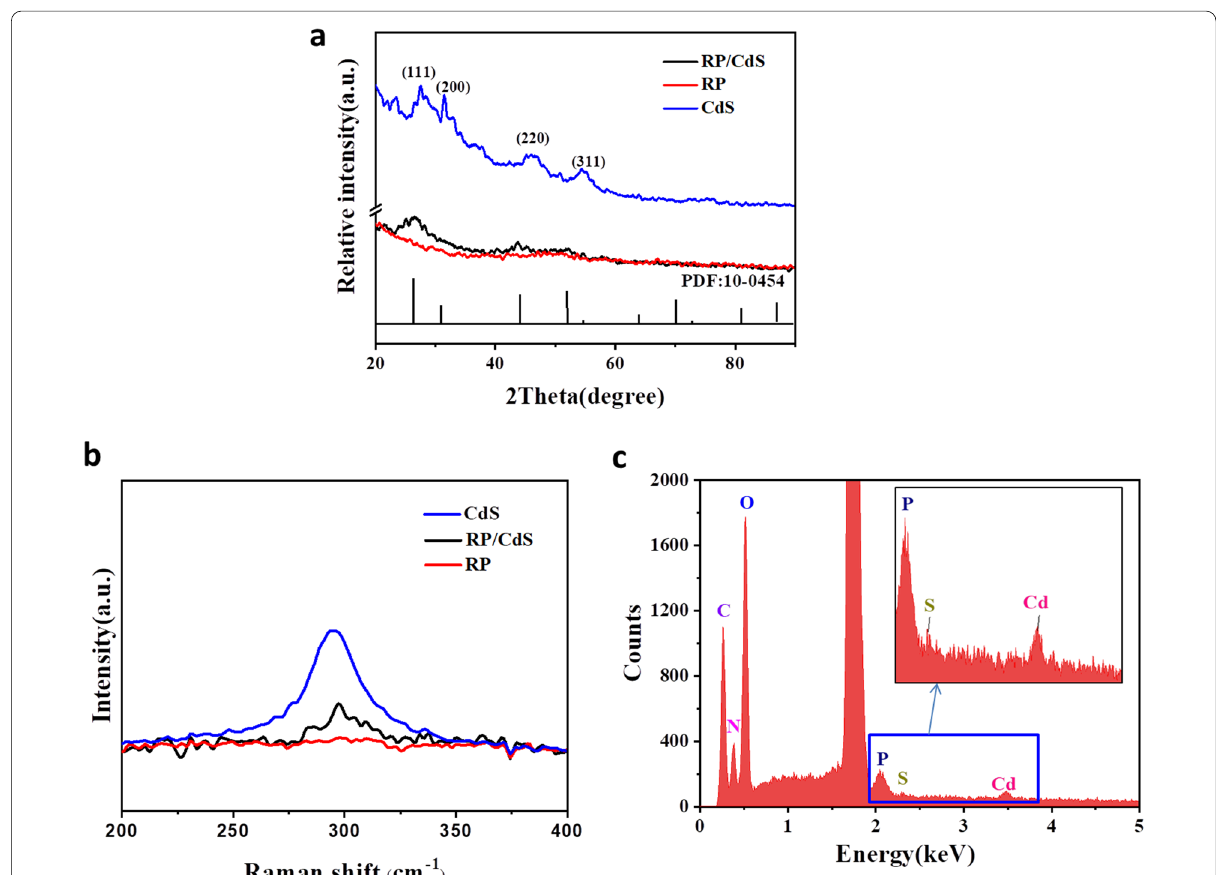
Fig.2 Physico‑chemical characterization of RP/CdS bio‑nano‑hybrid cells. a XRD patterns of CdS QDs, RP cells and RP/CdS hybrid cells. The number in the image indicates the crystalline facet of the corresponding peak. b Raman spectra of CdS QDs, RP cells and RP/CdS hybrid cells. c EDS analysis of RP/CdS hybrid cells. The inset indicates the enlarged view of the selected